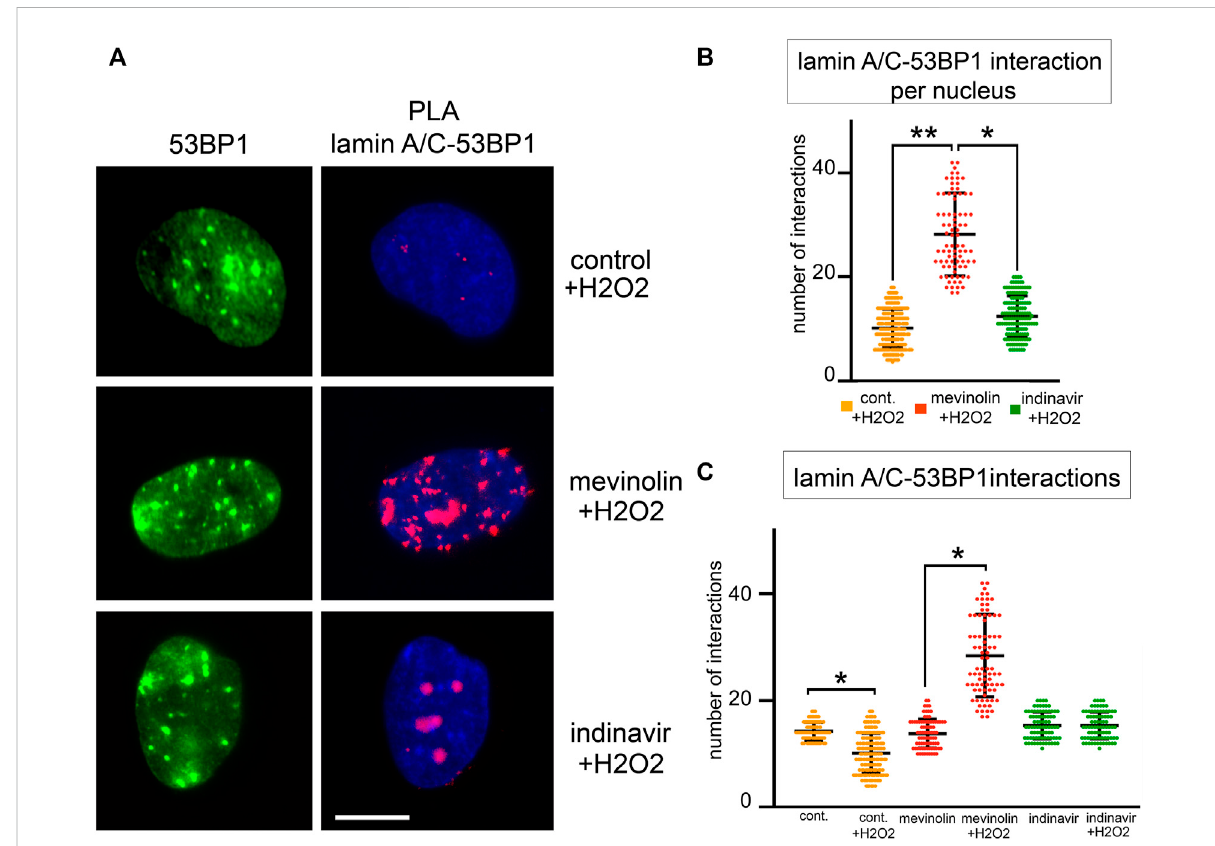
FIGURE 4 53BP1-lamin A/C binding in human dermal fi broblasts accumulating prelamin A subjected to oxidative stress. (A) Proximity ligation assay (PLA) showing lamin A/C-53BP1 interactions in untreated, mevinolin- and indinavir-treated fi broblasts upon oxidative stress induction. 53BP1 was detected by immuno fl uorescence labeling with a speci fi c antibody (green). Interactions between lamin A/C and 53BP1 are revealed as red PLA signals. Chromatin was counterstained with DAPI (blue). Bar, 10 μ m. (B) Dot plot showing the number of PLA signals per nucleus in fi broblasts subjected to oxidative stress. Experiments were conducted in triplicate and 100 nuclei per sample were analyzed. Comparison between the groups wasdeterminedbyusingtheone-wayANOVAtest.Errorbars,mean±SD.Asterisksshowstatisticalsigni fi cance(*, p < 0.05;**, p < 0.01). (C) Dotplot comparing PLA signals corresponding to lamin A/C-53BP1 interactions in fi broblasts left untreated (control) or subjected to H2O2 for 4 h (+H2O2). Untreated cells (cont.), mevinolin treated cells (mevinolin), indinavir treated cells (indinavir). Experimentswere conducted in triplicate and 100 nuclei per sample were analyzed. Comparison between the groups was determined by using the one-way ANOVA test. Error bars, mean ± SD. Asterisks show statistical signi fi cance (*, p < 0.05; **, p <